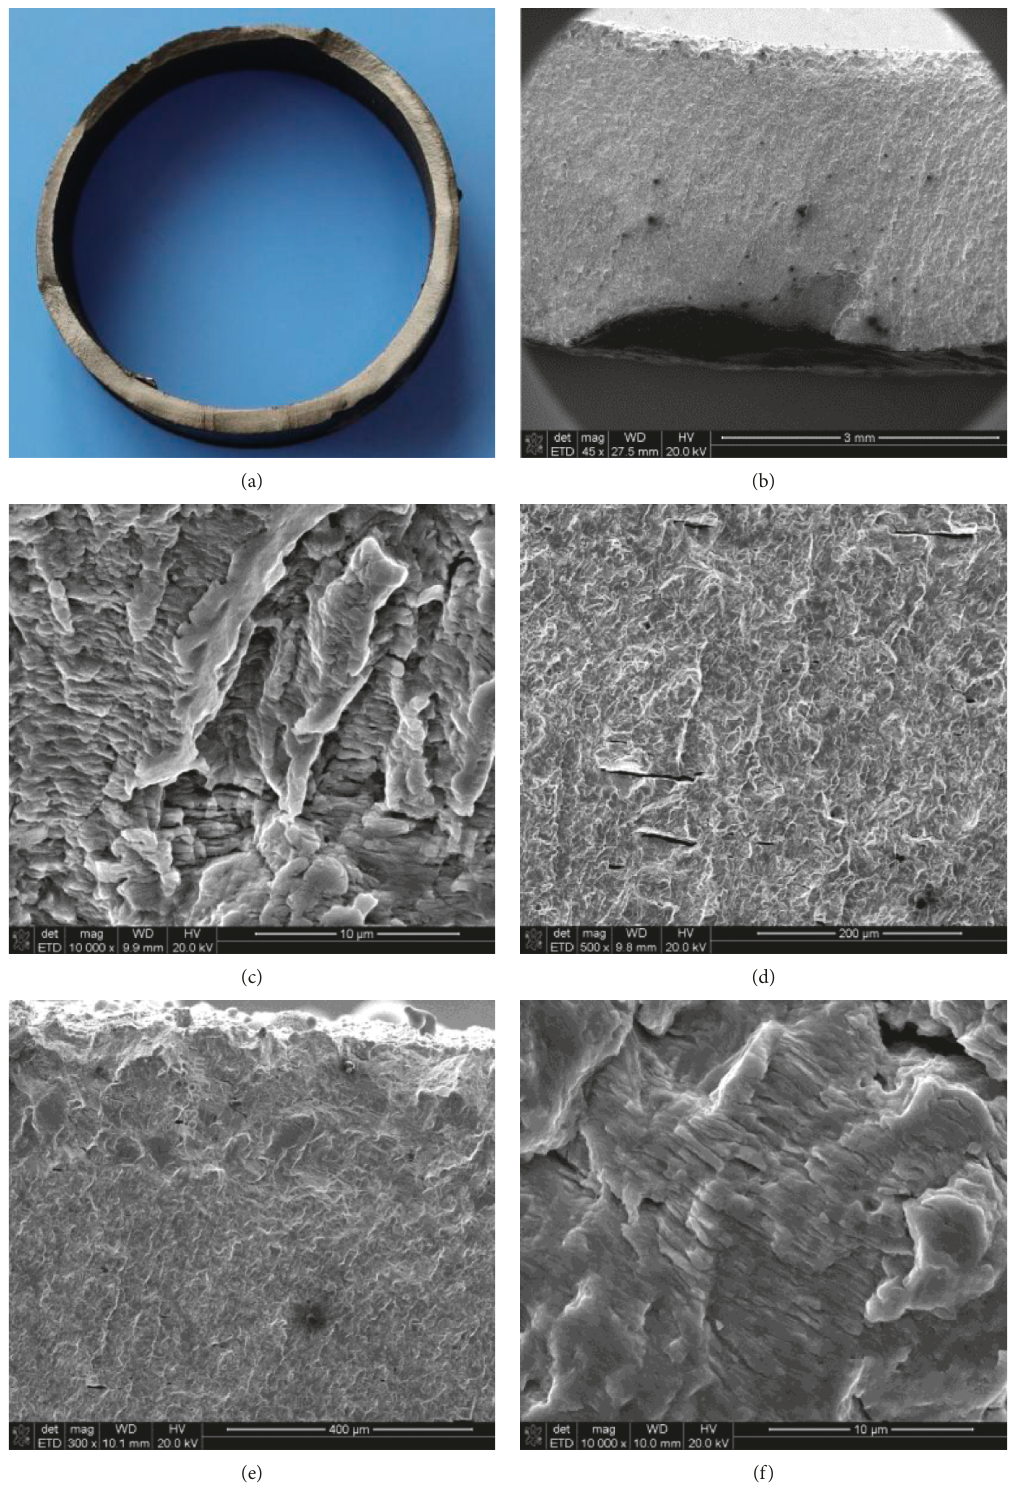
Figure 13: Typical fracture images (stress amplitude � 123MPa and stress ratio � 0.4). (a) Macroimage. (b) Micrograph of fatigue initiation zone. (c) Micrograph at 1mm from the outer wall. (d) Micrograph at 2mm from the outer wall. (e) Micrograph near the inner wall with 300 times. (f) Micrograph near the inner wall with 10000